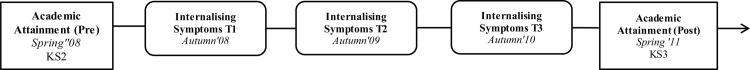
Study design illustrating when data for key variables—educational attainment and internalising symptoms, were collected.